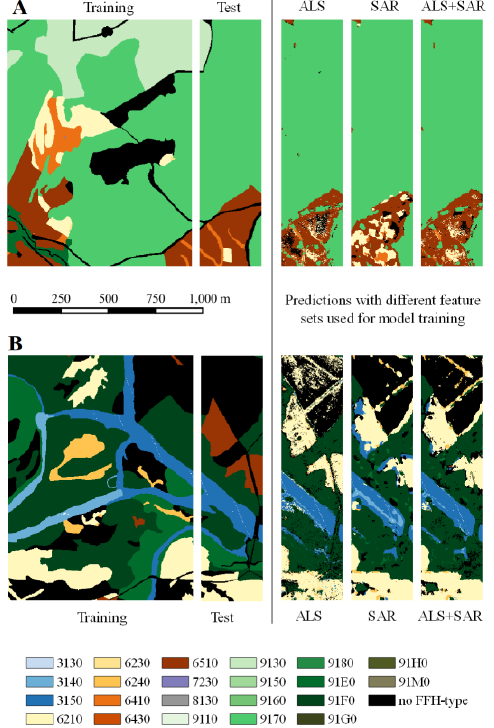
Figure 3. Tiles (1.3 km × 1.3 km) for first training and testing of RF models for FFH type classification. The tiles are spatially split in 75% training area for training of the model and 25% test area for validation of the predictions. A: tile within research area Vienna Woods (study site A). B: tile within research area Donau-Auen National Park (study site B). The left side shows the results of the application of the trained models on the test data using different set of input features for model